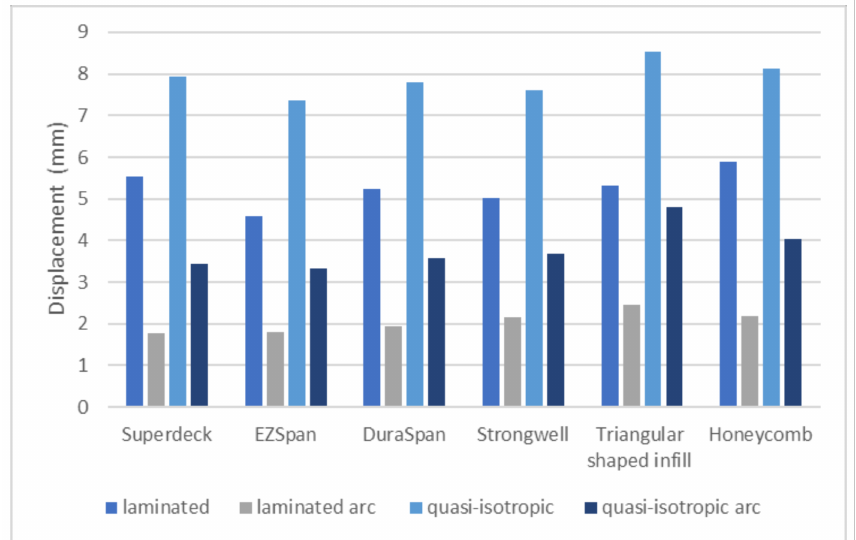
Figure 11. Results for displacements.